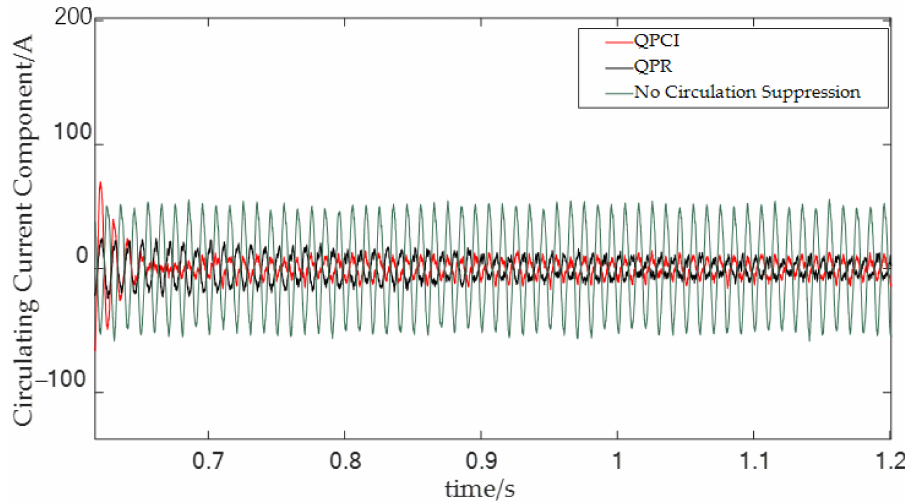
Figure 7. Simulation waveforms of double frequency circulating current suppressing